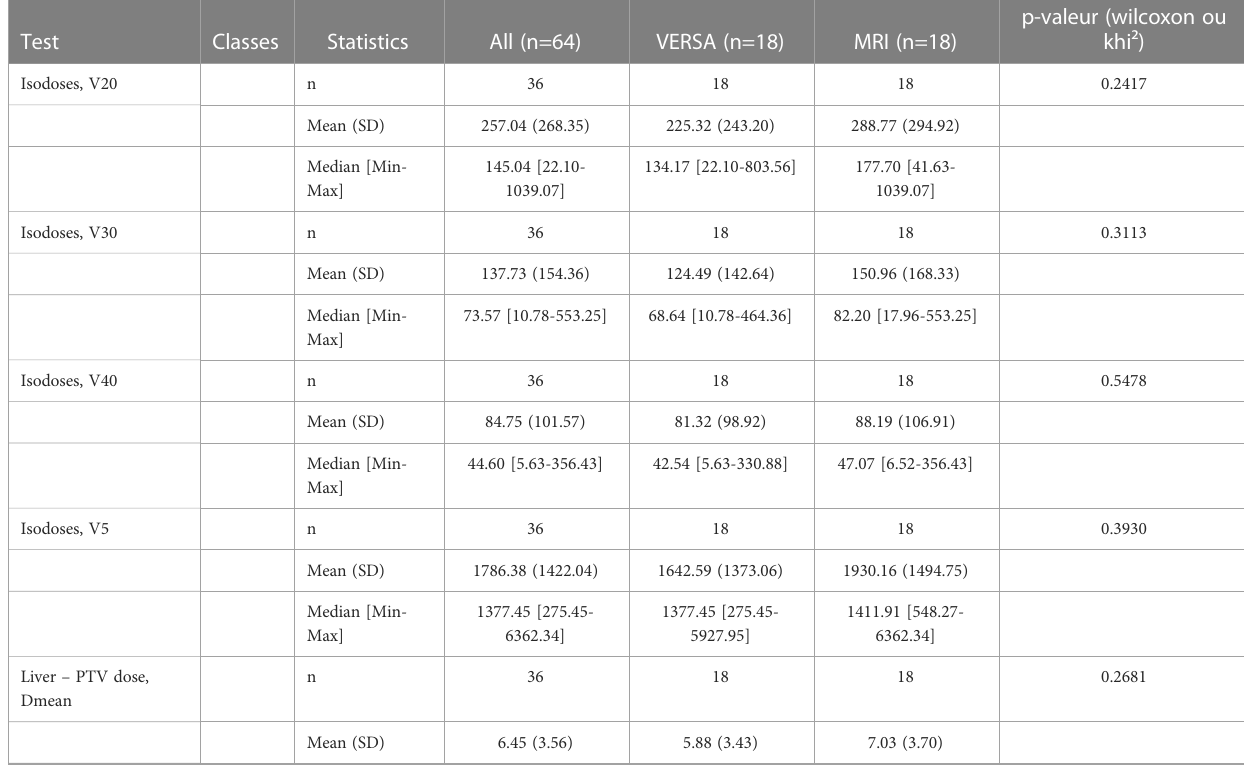
TABLE 4 Comparative dosimetry metrics in patients treated on the MRIdian system, secondarily calculated for a fi ctive treatment on the VERSA-HD.